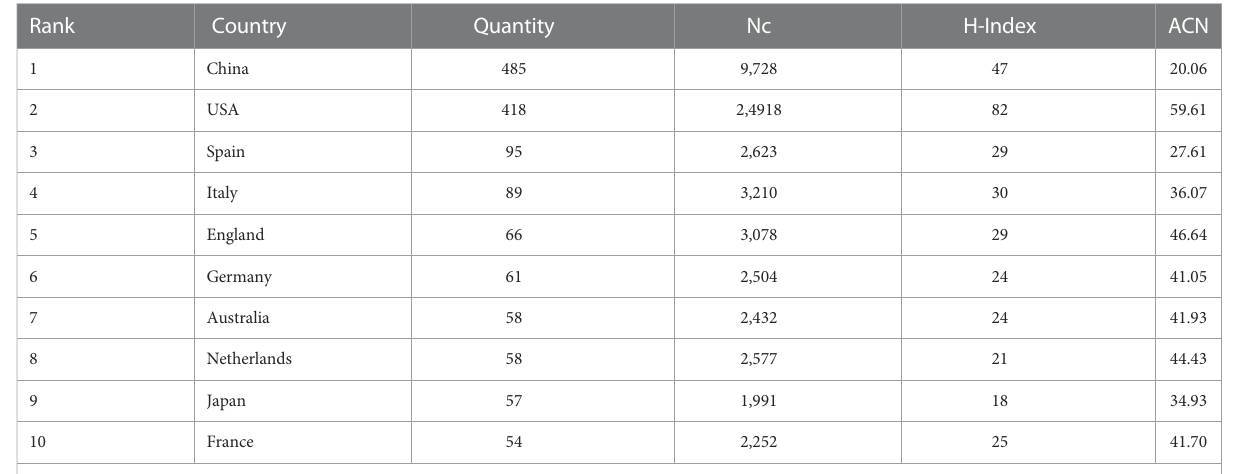
TABLE 1 The top 10 countries related to GM in CVD.